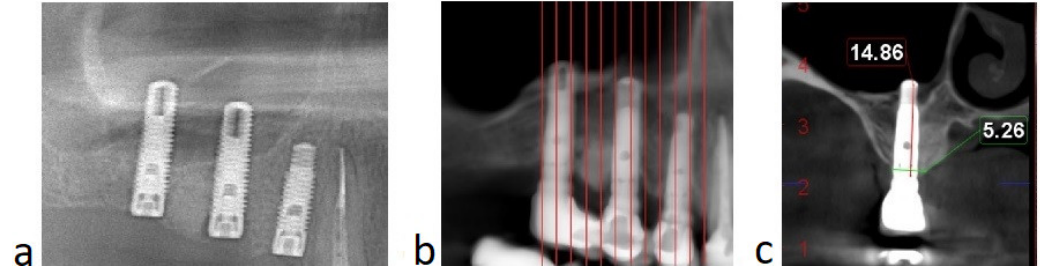
Figure 6. (Case no. 4) Radiological aspect of the sinus floor augmentation performed with PRFs, with different degrees of radiodensity: immediately after the surgery ( a ); and 12 months after the procedure ( b ). Specific image of sinus augmentation with PRF where the tip of the implant (1–1.5 mm) has formed no bone, due to Schneiderian membrane pressure during the new bone formation process ( c ).